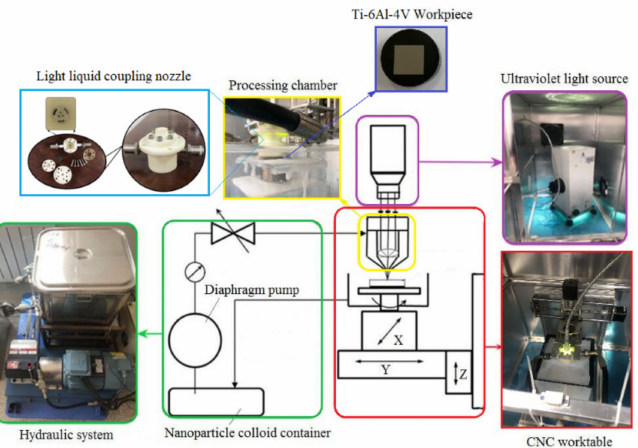
Figure 1. Experimental equipment of UV-induced nanoparticle colloid jet